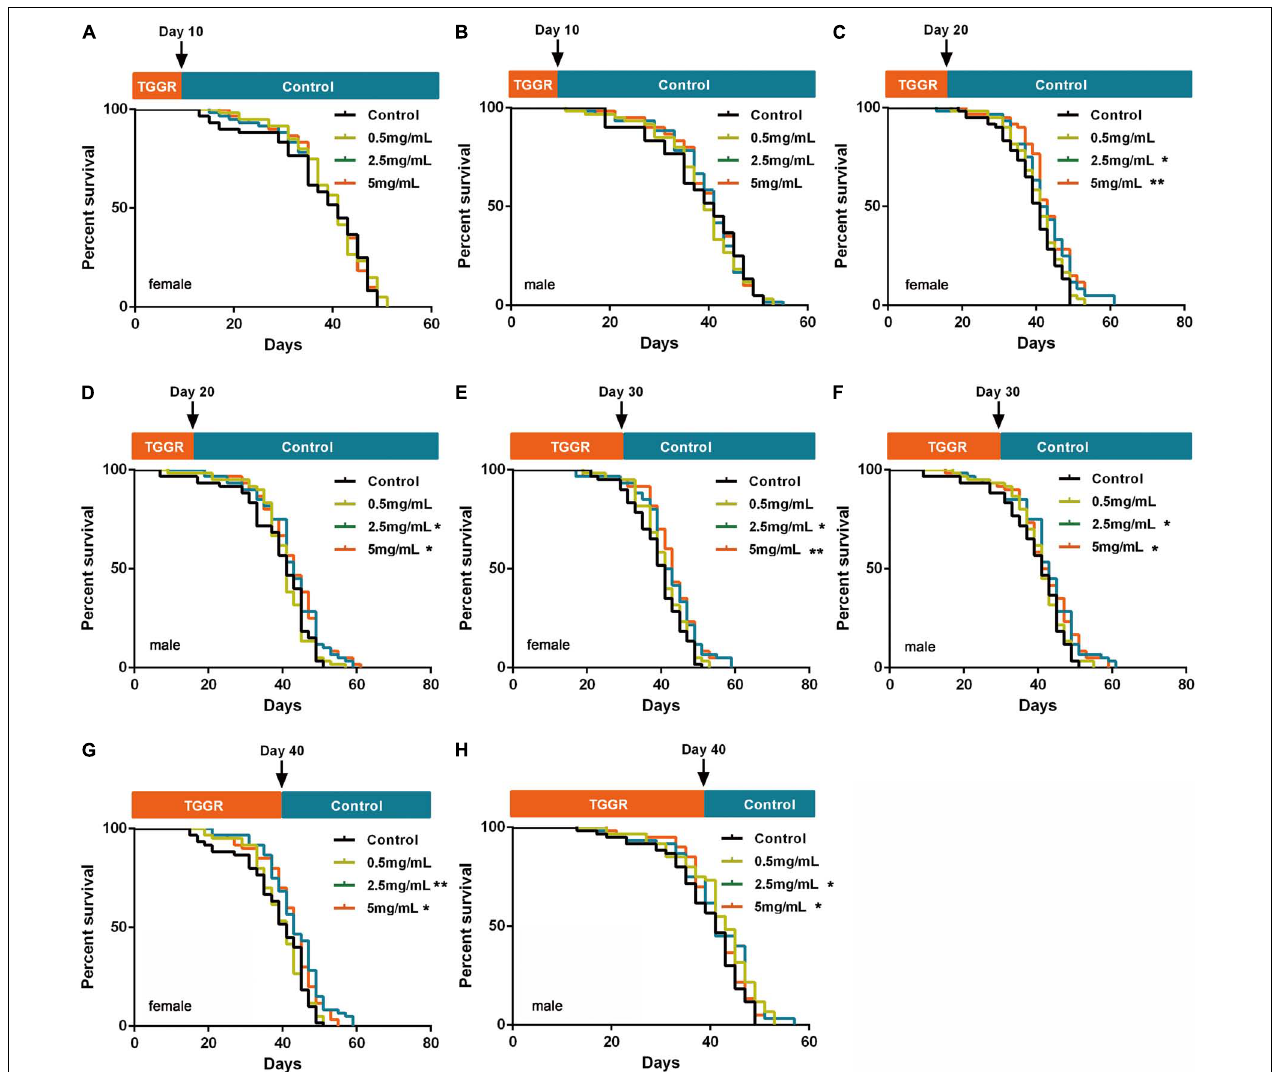
FIGURE 2 | Screening of TGGR treatment duration. Short-term treatment with TGGR for 10 days early in adulthood of female (A) and male (B) flies. Medium-term treatment with TGGR for 20 days in female (C) and male (D) flies. Treatment with TGGR for 30 days in female (E) and male (F) flies. Long-term treatment with TGGR for 40 days in female (G) and male (H) flies. N = 120 flies per condition, Log-rank (Mantel-Cox) test. * p < 0.05, ** p < 0.01 vs. the